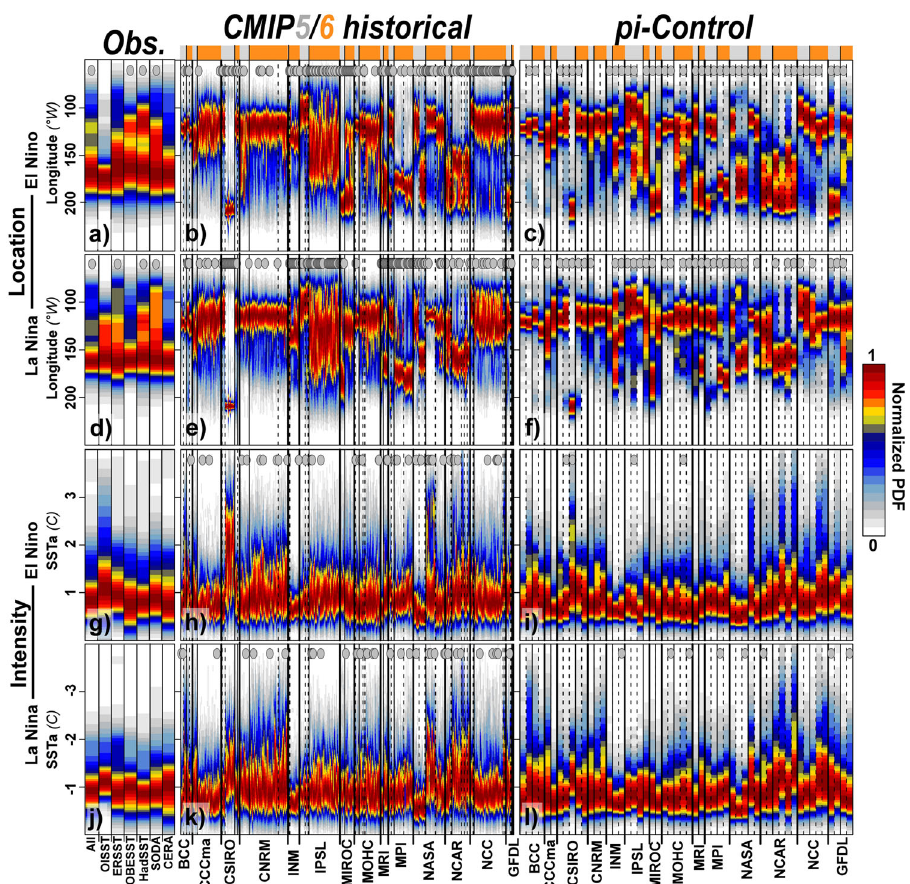
Fig. 3 Likelihood of ENSO ’ s location and intensity in CMIP5 and CMIP6 models. Normalised PDF of El Niño location in ( a ) all reference datasets, as compared with ( b ) 95/250 CMIP5/6 historical runs, as well as in ( c ) 26/28 CMIP5/6 piControl runs. d – f Same as ( a – c ) but for La Niña. g – l Same as ( a – f ) but for El Niño and La Niña intensity. On top of each panel and column, grey dots indicate signi fi cant multimodality at p = 0.05 according to the ACR test 88 , based on 1000 bootstrap resamples. The normalised PDF is estimated using the full length of each time series, ranging from 37 years in OISST.v2 to 1200 years in some piControl simulations. Bold (thin) solid lines separate simulations from different institutions (generations, i.e., CMIP5 [grey] and CMIP6 [orange]), while dashed lines separate simulations from different